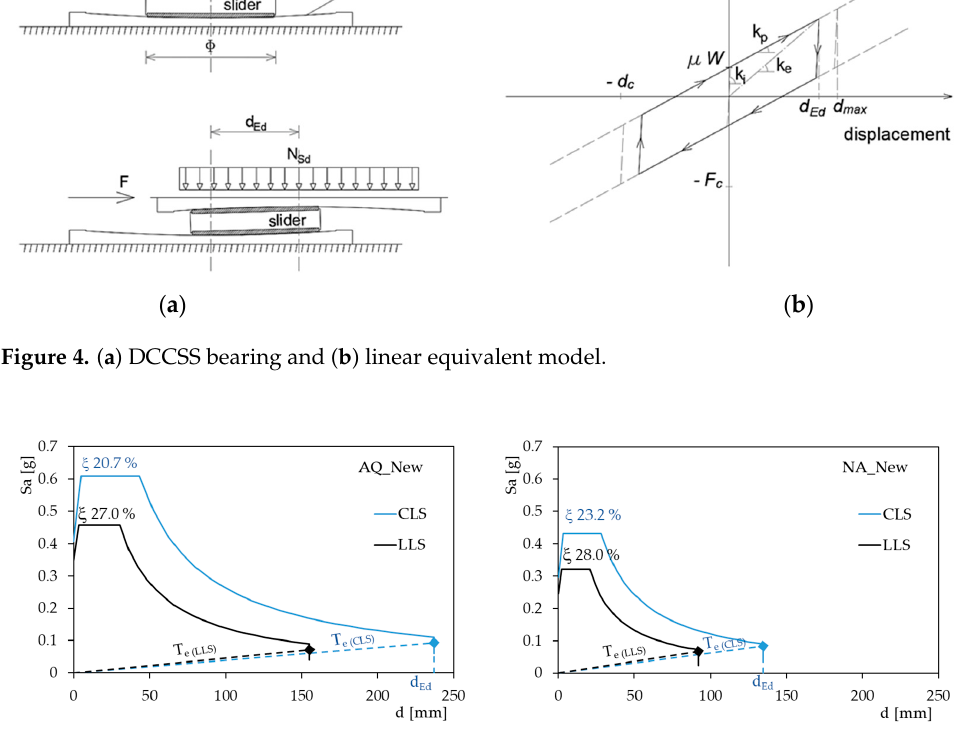
Figure 5. Isolation system design procedure on CLS and LLS spectra for the cases of New construction building in the site of L’Aquila ( a ) and Naples ( b ).